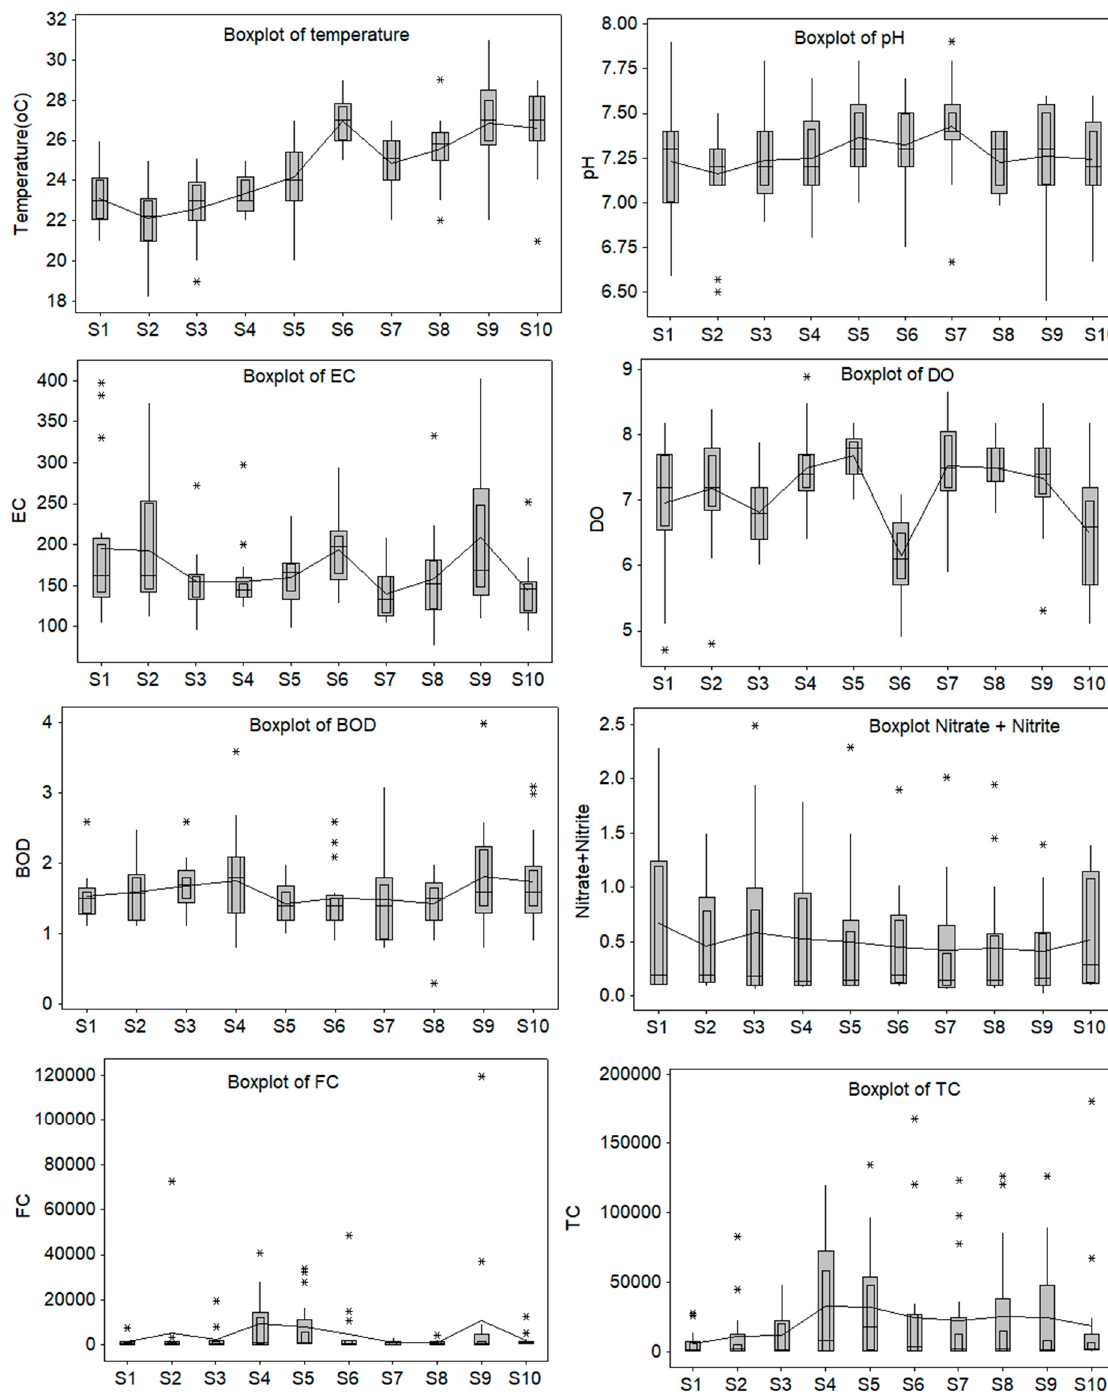
Figure 2. Boxplots of the water parameters; from top to bottom and left to right: temperature, pH, EC, DO, BOD, Nitrate and Nitrite, FC, and